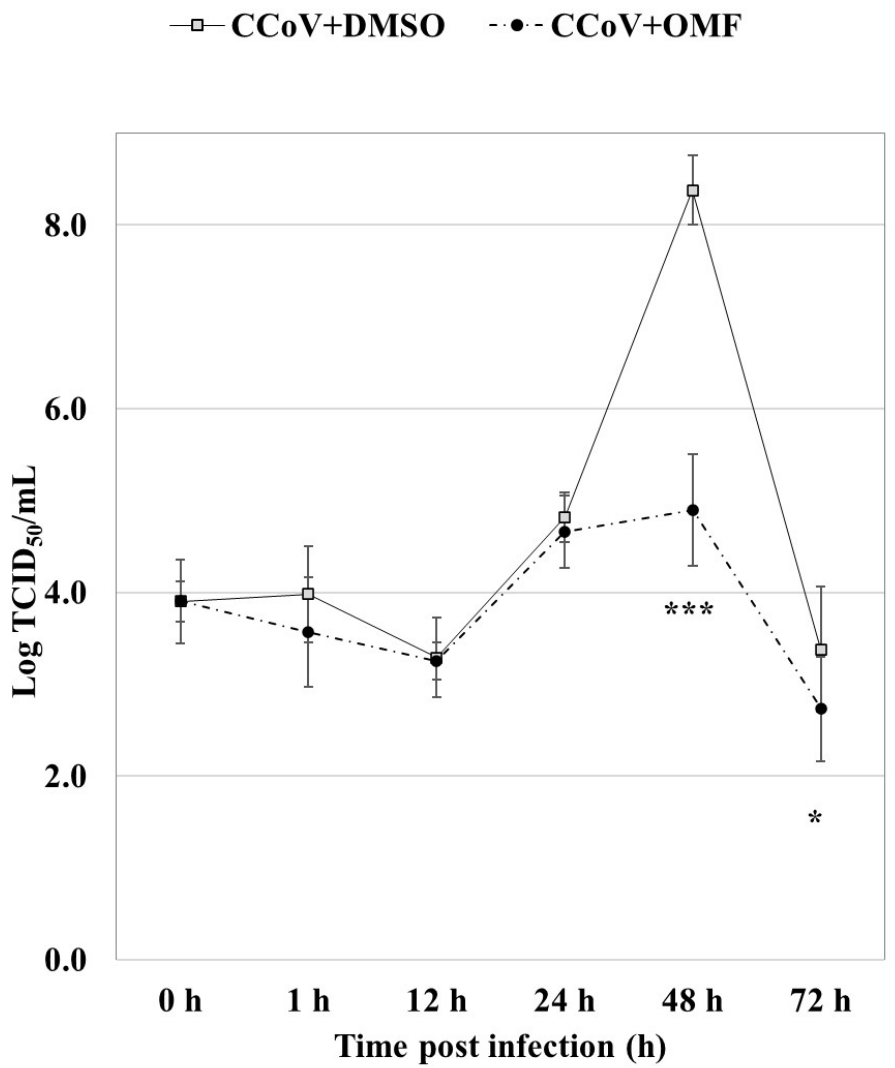
Figure 5. OMF diminished virus titer during CCoV infection in A72 cells. For viral growth curves, A72 cells were infected with CCoV at a MOI of five, exposed or not to OMF. At indicated times post infection, virus titers were assessed using RT-qPCR. Significant differences between CCoV-infected cells and OMF-treated infected cells were shown by probability p . *** p < 0.001 and * p < 0.05. To investigate the influence of OMF on AhR protein expression during CCoV infection in A72 cells, immunofluorescence (IF) staining was carried out. In the control group, represented by uninfected cells, we found that AhR was expressed [20], whereas in OMF- exposed cells, a downregulation of AhR protein expression was detected (Figure 6a). This result was proven using integrated density fluorescence measurement (Figure